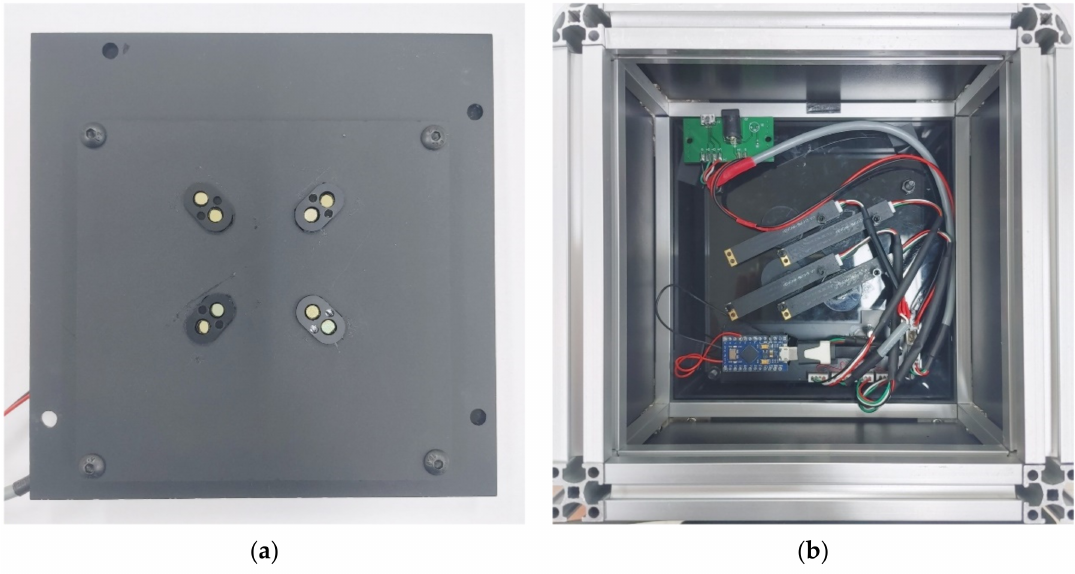
Figure 4. ( a ) Front of the imaging system; ( b ) Back of the imaging system.